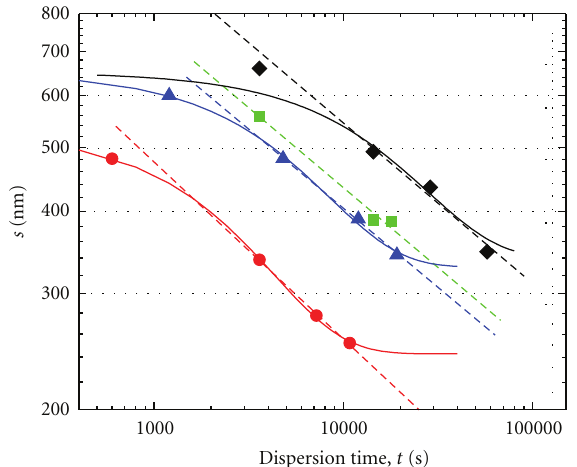
Figure 18: Agglomerate size data at 20% and 40% amplitude were fitted using (4) (dotted lines), and (7) (solid lines). Marquardt non- linear curve fit did not give converging results for the other two datasets. Eqution (7) was plotted with estimated parameters as a guide for data from the bath sonicator. Amplitudes 10% ( (cid:2) ), 20% ( (cid:4) ), 40% ( • ), bath sonicator ( (cid:3)